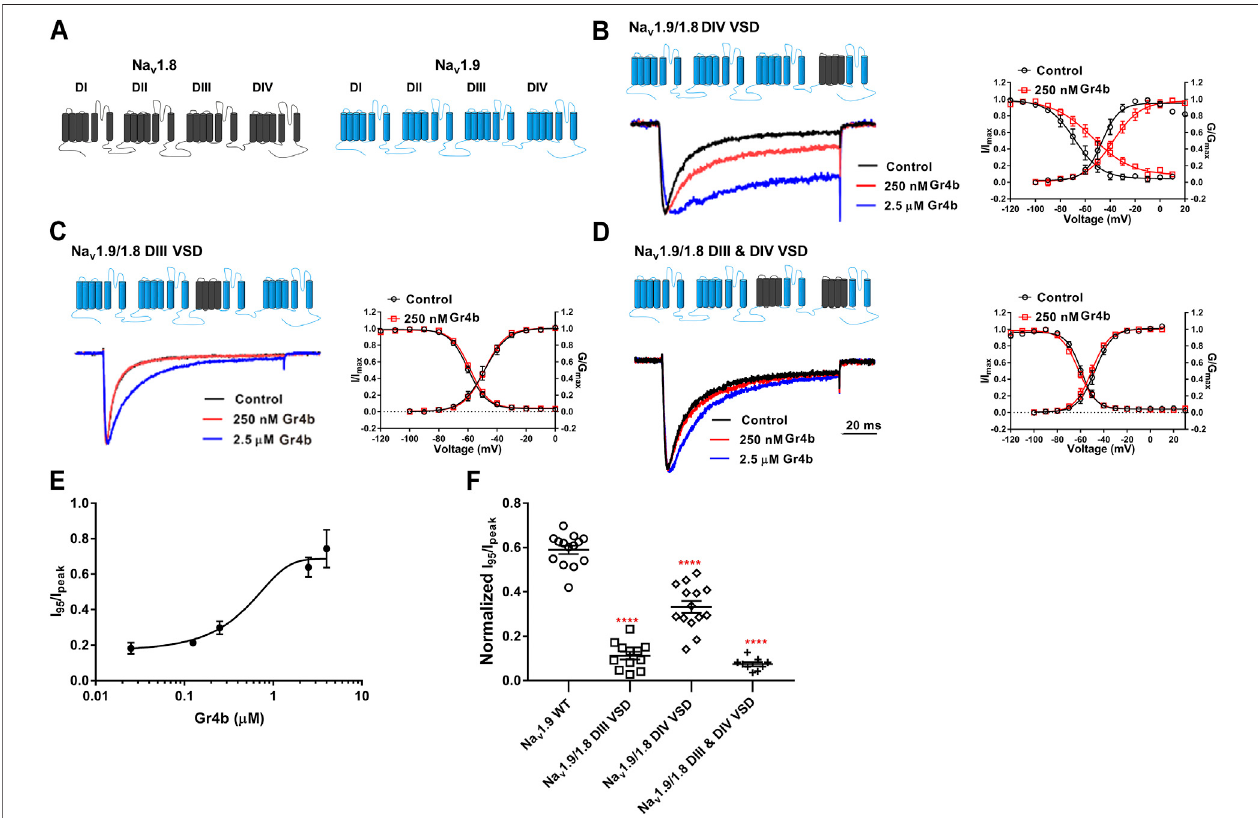
FIGURE 5 | DIII VSD and DIV VSD of Na v 1.9 is involved in interacting with Gr4b. (A) The topological structure of Na v 1.9 (blue) and rNa v 1.8 (grey), the numbers indicated the border of the transmembrane domains. (B – D) Representative normalized current traces, voltage-dependent steady-state activation and voltage- dependent steady-state inactivation show thatthe chimera channels (constructed as thecartoon illustrated) Na v 1.9/1.8 DIV VSD, Na v 1.9/1.8 DIII VSD, Na v 1.9/1.8 DIII & DIV VSD, in the absence (black), presence of 250 nM Gr4b (red) or 2.5 μ M Gr4b (blue). (E) The dose-response curves for the Gr4b-induced inhibition of the fast inactivation of Na v 1.9/1.8 DIV VSD, EC 50 of 1.5 ± 0.25 μ M (n (cid:2) 4). (F) The effect of Gr4b on the channel of WT and Na v 1.9/1.8 chimeras. Dot plots display the effect of 250 nM Gr4b on the persistent current (I 95 /I peak ) (n (cid:2) 14 for WT; n (cid:2) 12 for Na v 1.9/1.8 DIII VSD, n (cid:2) 14 for Na v 1.9/1.8 DIV VSD and n (cid:2) 9 for Na v 1.9/1.8 DIII & DIV VSD). One-way ANOVA with Dunnett ’ s Multiple Comparison Test and compared with WT, **** p < 0.0001.